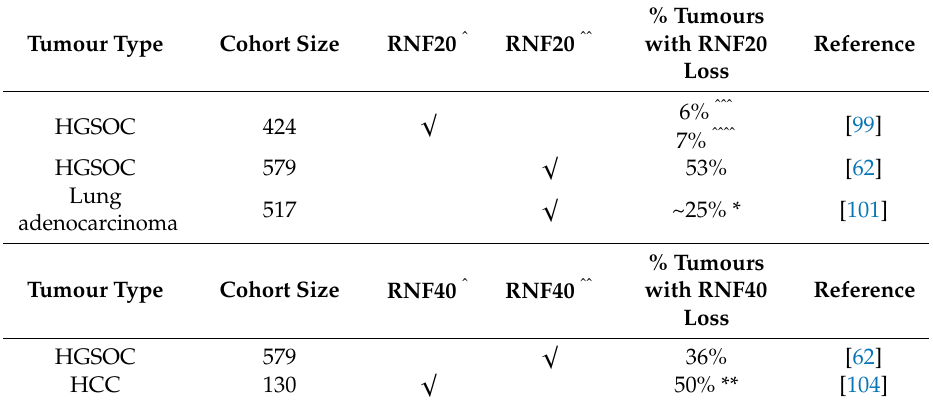
Table 2. RNF20 and RNF40 loss in primary